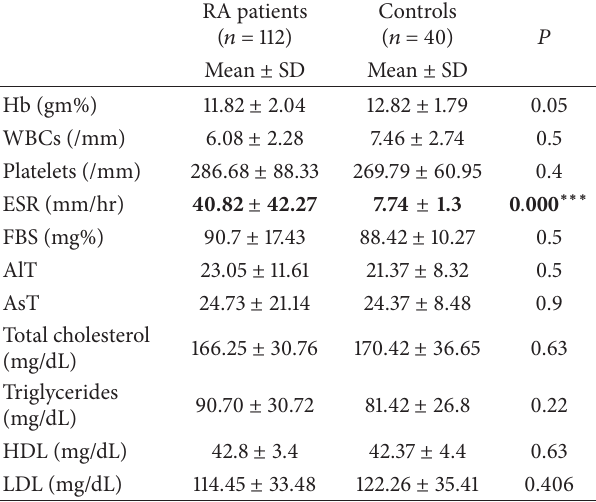
Table 2: Laboratory features of RA patients and